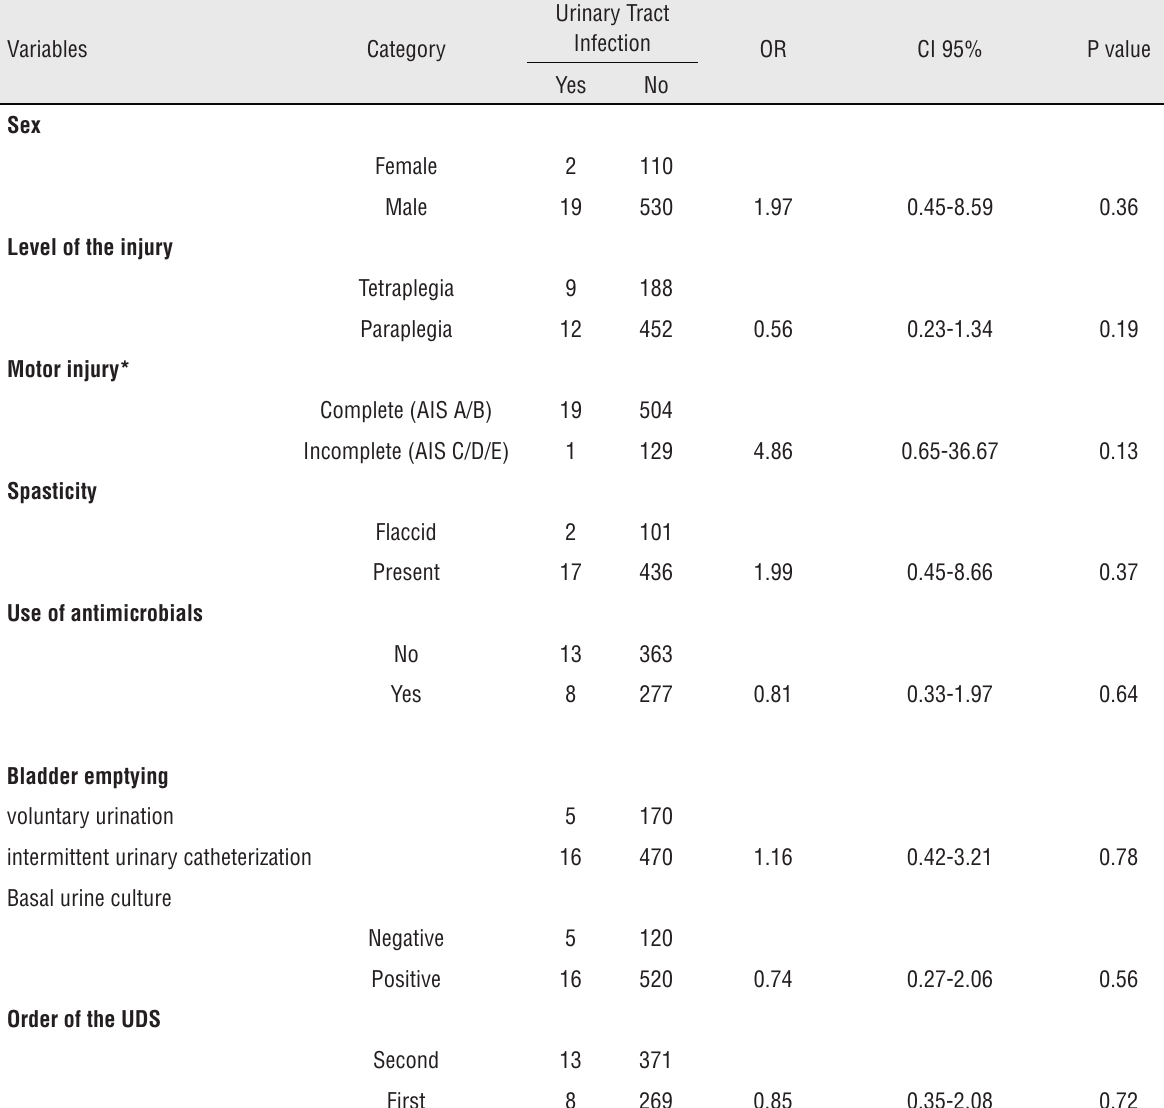
Table 1 - Categorical variables in the groups of patients with and without urinary tract infection after the UDS, with their respective odds ratios (OR; univariate analysis), confidence interval of 95% (CI 95%) and statistical significance. Urinary Tract Infection OR Variables Category